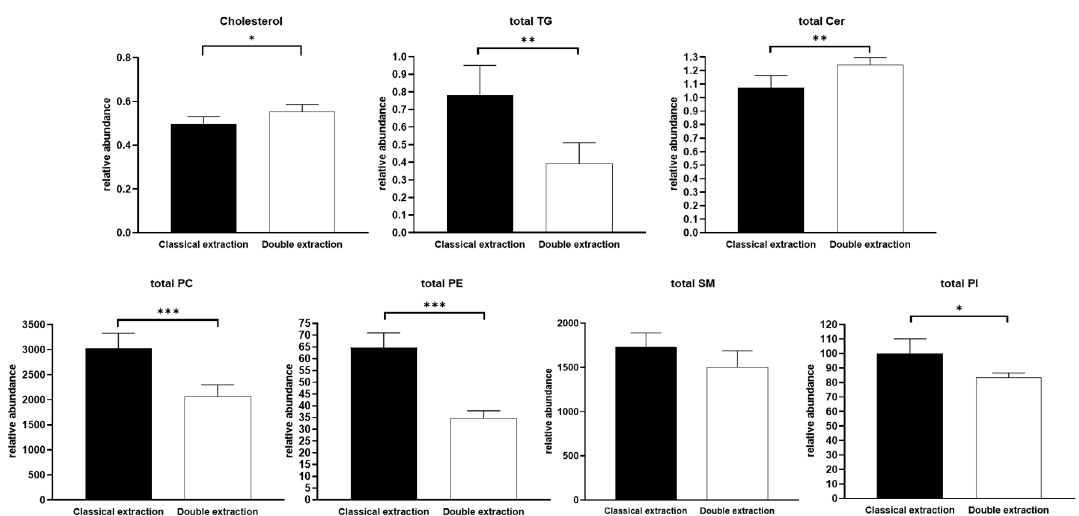
Figure 4. Comparison of lipid classes quantitative recovery between classical and double extraction methods. Total lipids classes correspond to an addition of all molecular species (ratio with their internal standard) obtained for each class. Bars represent mean ± SD (n = 5). t -tests were performed for each metabolite (* p < 0.05; ** p < 0.01; *** p < 0.001). Triglycerides (TG), ceramides (Cer), phosphatidylcholines (PC), phosphatidylethanolamines (PE), sphingomyelins (SM), phosphatidylinositols (PI).